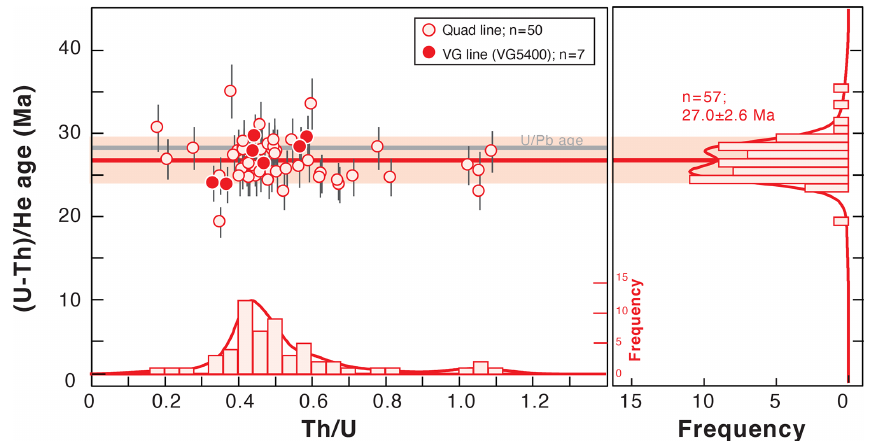
Figure 9. Fish Canyon Tuff zircon (U–Th) / He age dispersion (1 σ shown) as a function of the Th / U ratio for the data obtained in 2018 using the quad and VG lines. Histogram representations of the (U–Th) / He ages and Th / U ratios were constructed using RadialPlotter (Vermeesch, 2009). A U / Pb age of 28.5 ± 0.06Ma has been published by Schmitz and Bowring (2001). Th / U is expressed by